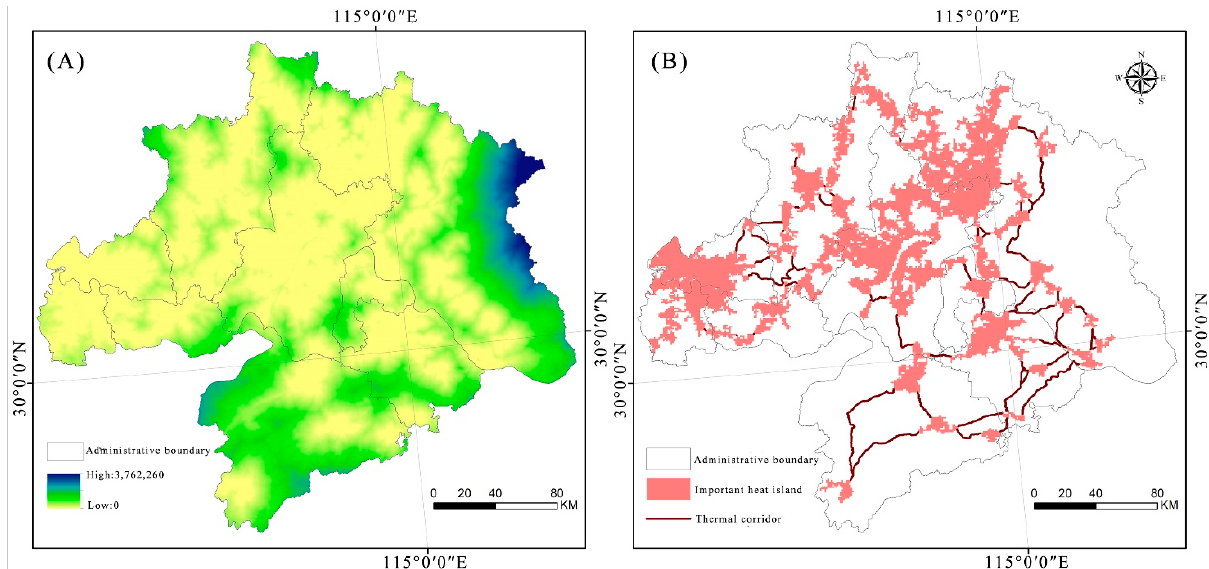
Figure 5. Distribution of minimum cumulative resistance ( A ) and the thermal corridor ( B ).